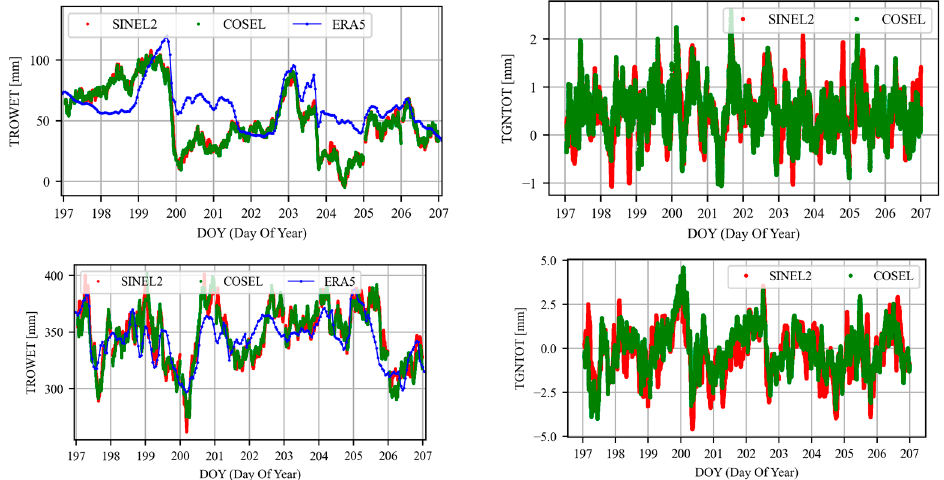
Figure 2. Time series of ZWD (TRPWET) and the north gradient difference (TGNTOT) from differ- ent schemes for station RGDG (top) and PNGM